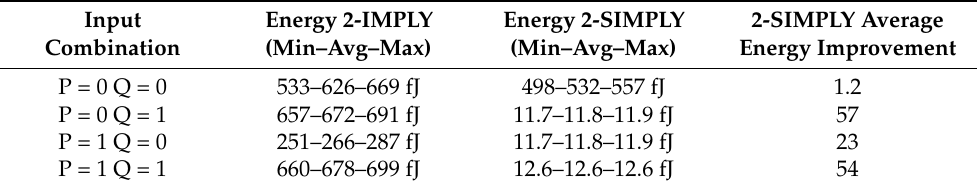
Table 2. Energy consumption of FALSE operation in IMPLY and SIMPLY architectures for different RRAM